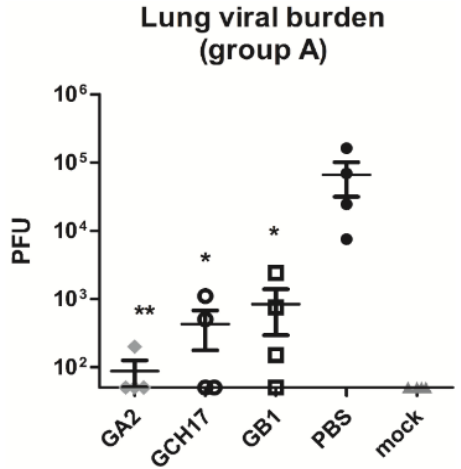
Figure 6. Lung virus titers following RSV challenge of mice vaccinated with LbL nanoparticles. Mice were vaccinated s.c. with LbL nanoparticles carrying the G protein Cx3C motif, challenged i.n. with 10 6 PFU RSV A2, and lung virus titers were determined at day 5 post-challenge. Lung virus titers were determined by immunostaining plaque assay. Data are presented as total PFU/whole lung tissue. Values shown as the mean ± SEM (one-way ANOVA); * p <0.05; ** p < 0.005 vs . PBS vaccinated